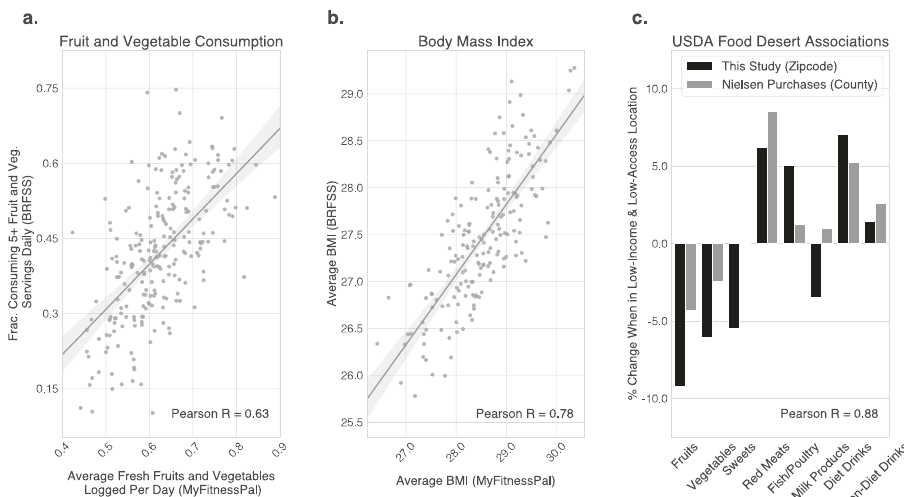
Fig. 3 This studies ’ smartphone-based food logs correlate with existing large-scale survey measures and purchase data. a Fraction of fresh fruits and vegetables logged is correlated with BRFSS survey data 43 (Pearson Correlation R = 0.63, p < 10 − 5 ; Two-sided Student ’ s t -test; Methods). b Body-mass index of smartphone cohort is correlated with BRFSS survey data 44 (Pearson Correlation R = 0.78, p < 10 − 5 ; Two-sided Student ’ s t -test; Methods). Lines in a , b show best linear fi t along with shaded 95% bootstrap con fi dence intervals. c Digital food logs replicate previous fi ndings of relative consumption differences in low-income, low-access food deserts based on Nielsen purchase data 45 (Pearson Correlation R = 0.88, p < 0.01; Two-sided Student ’ s t -test; Methods). These results demonstrate that smartphone-based food logs are highly correlated with existing, gold-standard survey measures and purchase